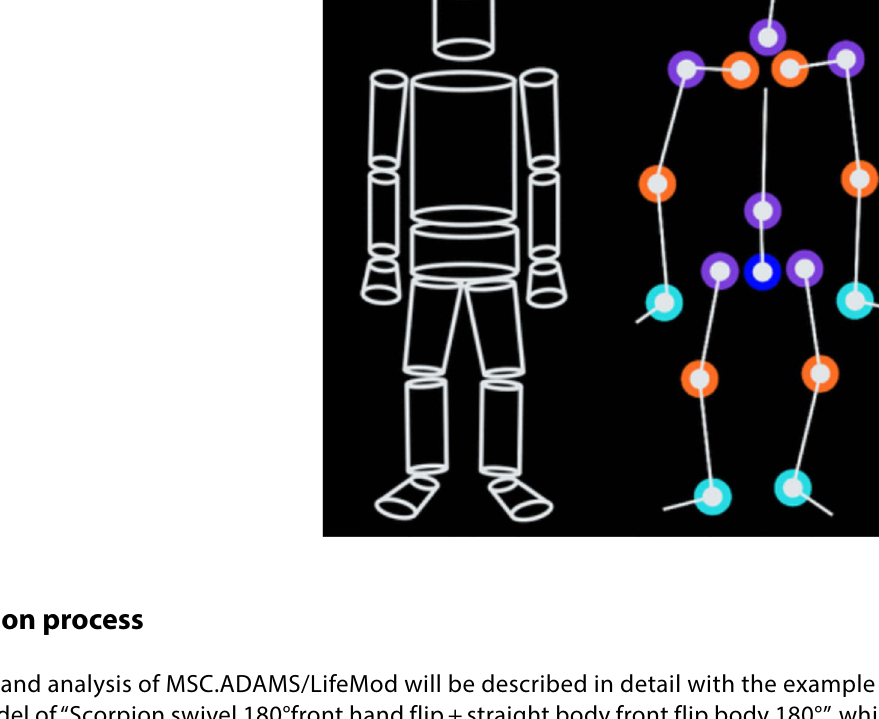
Fig. 2 Human body rigid model